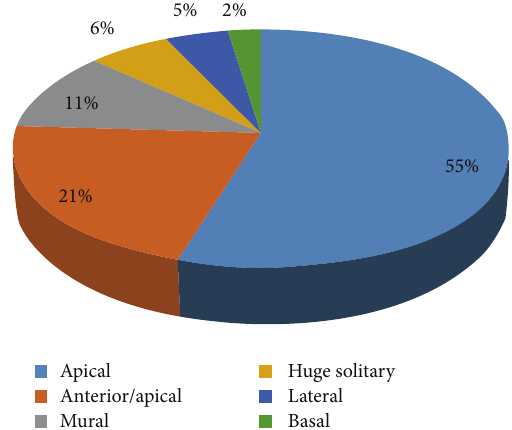
Figure 3: Locations of left ventricular thrombus observed.